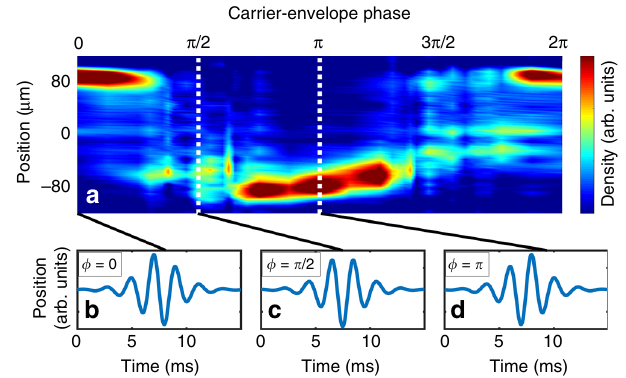
Fig. 6 Carrier-envelope phase dependence of fi nal momentum. a Integrated spatial density distribution after application of a near-resonant 450 Hz pulse with τ = 3.76 ms and A = 2.4 μ m followed by 3 ms of time of fl ight, versus CEP. b – d Pulse waveforms (force versus time) for CEP values indicated in the